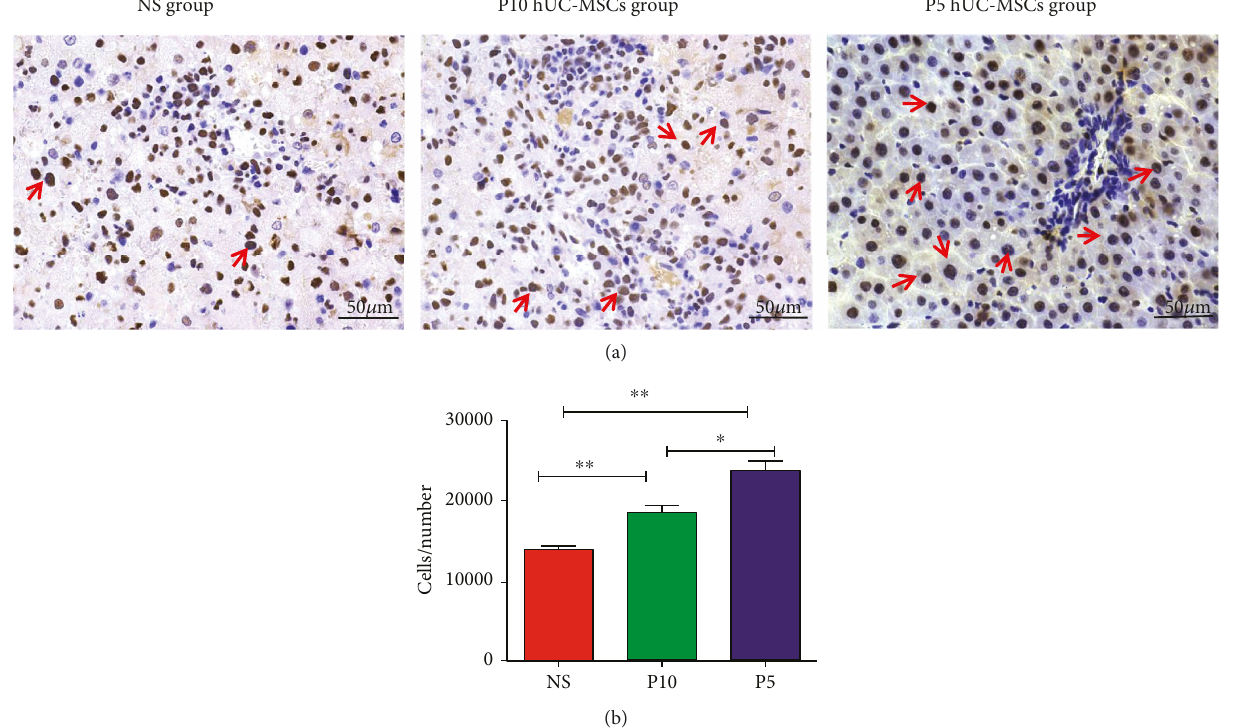
Figure 5: Infusion of hUC-MSCs enhances liver regeneration in livers D-GaIN/LPS-induced ALF at 48 h. (a) Liver sections were stained for PCNA (dark brown nuclei). Representative images from NS-treated, P10 hUC-MSC-treated, and P5hUC-MSC-treated rats. Bar=50 μ m. (b) Quanti fi cation of PCNA-positive hepatocyte-nuclei by Image-Pro Plus software. Data are reported as mean ± SD. ∗ P < 0 05 , ∗∗ P < 0 01 , ∗∗∗ P < 0 001 . PCNA, proliferating cell nuclear